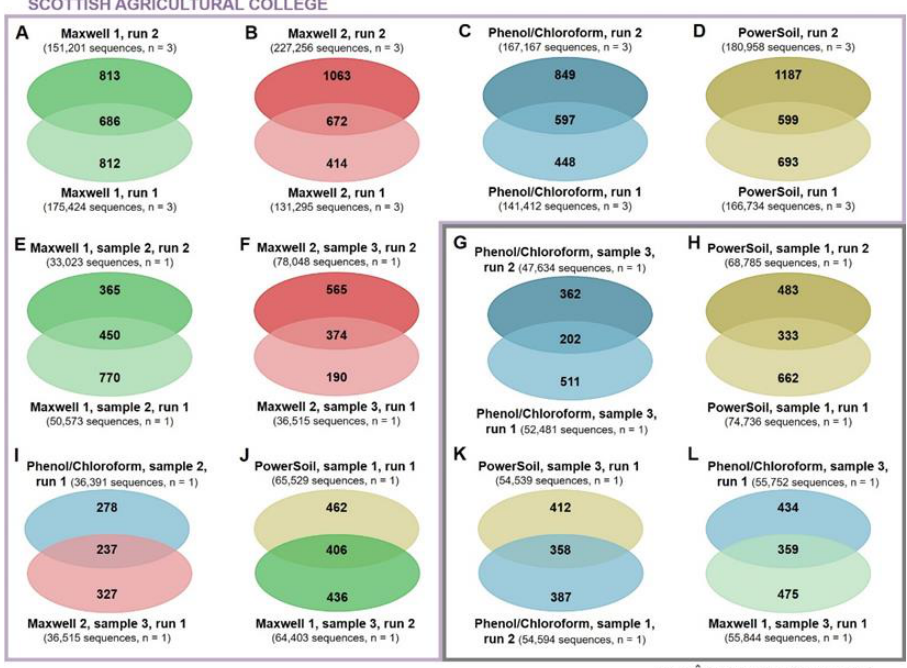
Figure 4. Venn Diagrams representing shared and unique ASVs from triplicates extracted using the same method sequenced in two different runs ( A – D ): individual samples sequenced at different depths ( E – H ) and samples extracted using different methods and sequenced at similar depths ( I – L ). Maxwell 1 and 2: modifications of the prototype Maxwell RSC Fecal Microbiome DNA Kit (Promega). PowerSoil: DNeasy PowerSoil Kit (QIAGEN).